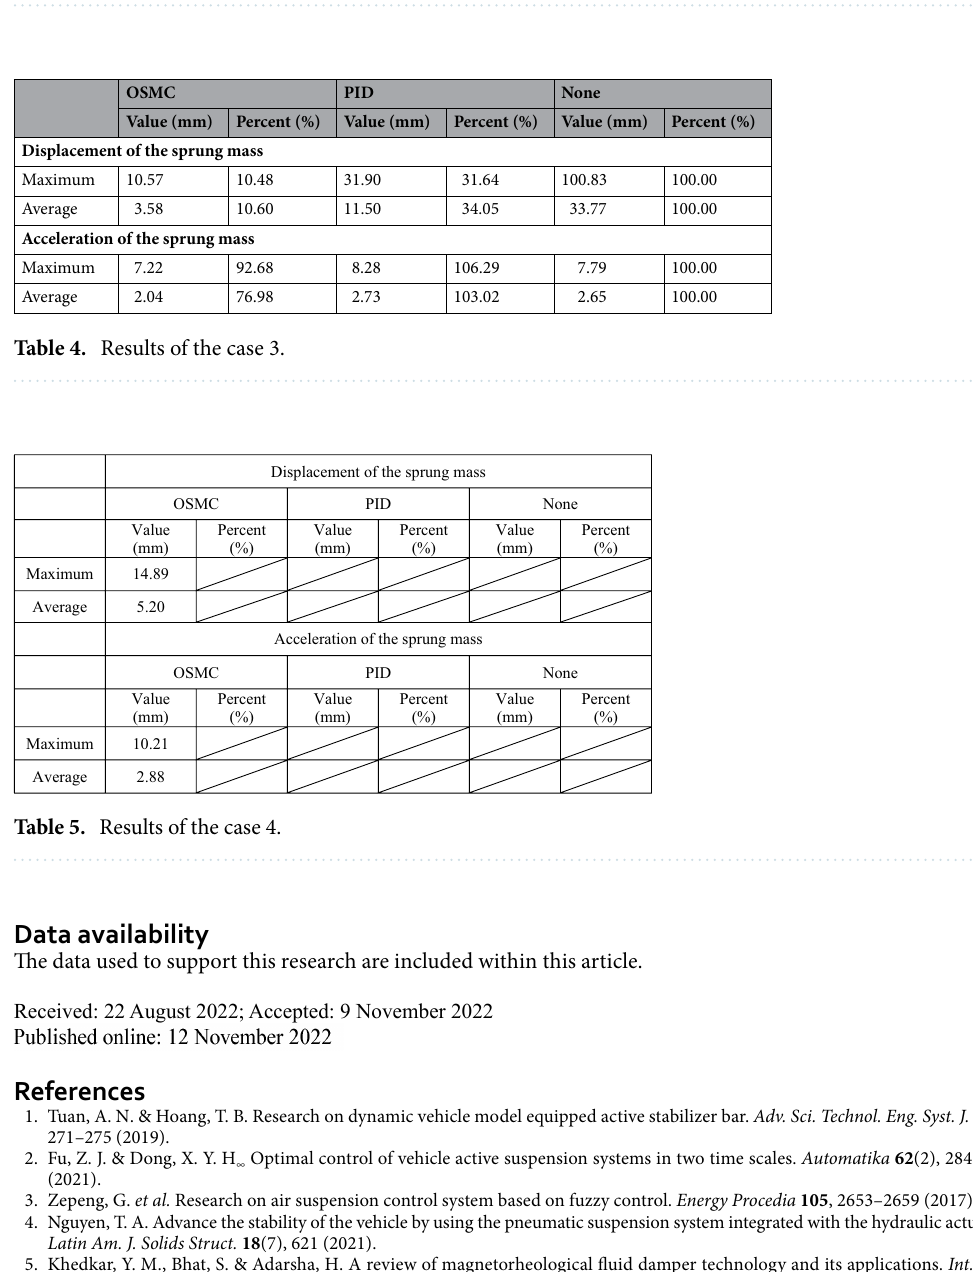
Table 3. Results of the case 2.